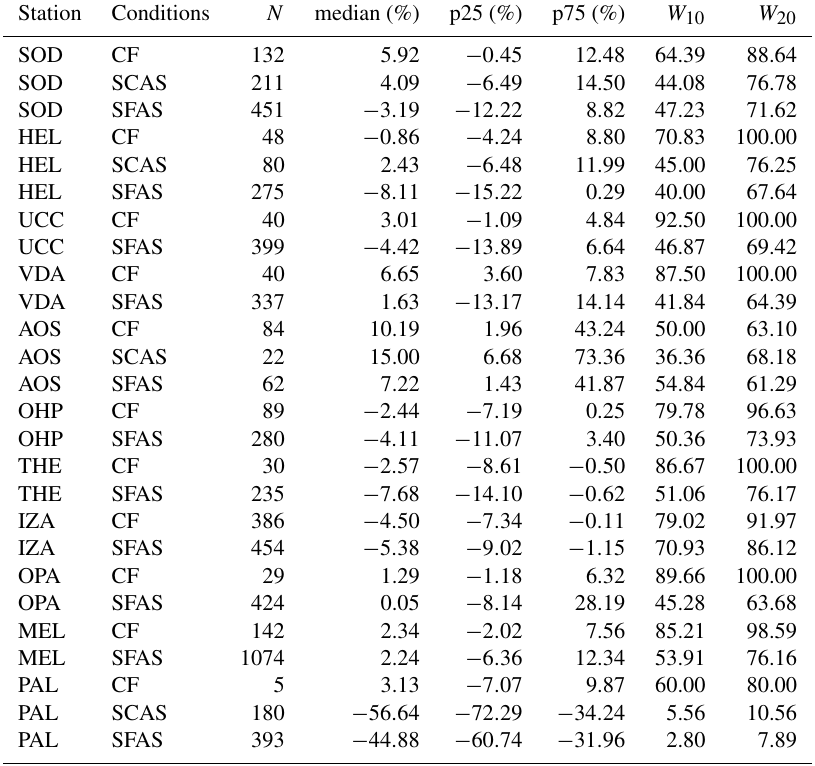
Table 5. TROPOMI overpass erythemally weighted dose rates compared to spectroradiometer measurements. The percentage relative dif- ferences 100% × ( sat − gr )/ gr, their medians (median), and the 25th (p25) and 75th (p75) percentiles were calculated. N is the number of measurement days included in the study. W 10 and W 20 are the percentages of satellite data which are within 10% and 20% of ground measurements. CF: cloud-free; SCAS: snow cover at ground, all sky; SFAS: snow-free ground, all